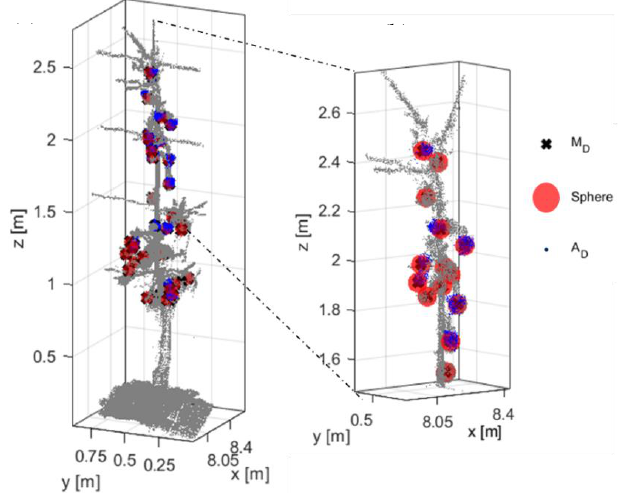
Figure 7. Detection of apple centers (M D ) using sphere segmentation (b) enlargement of upper zone of the tree with points of apples class enveloped in the sphere. The blue color depicts the apple points of the defoliated trees (A D ).